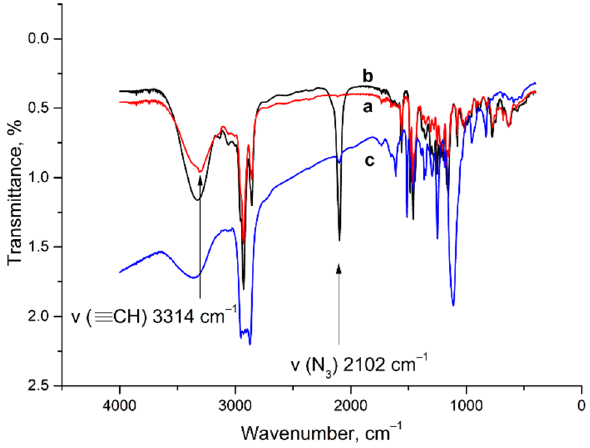
Figure 2. IR spectra (KBr pellets) of 1 ( a ), 2 ( b ), and mixture of 1 , 2 after cross-linkage ( c ).